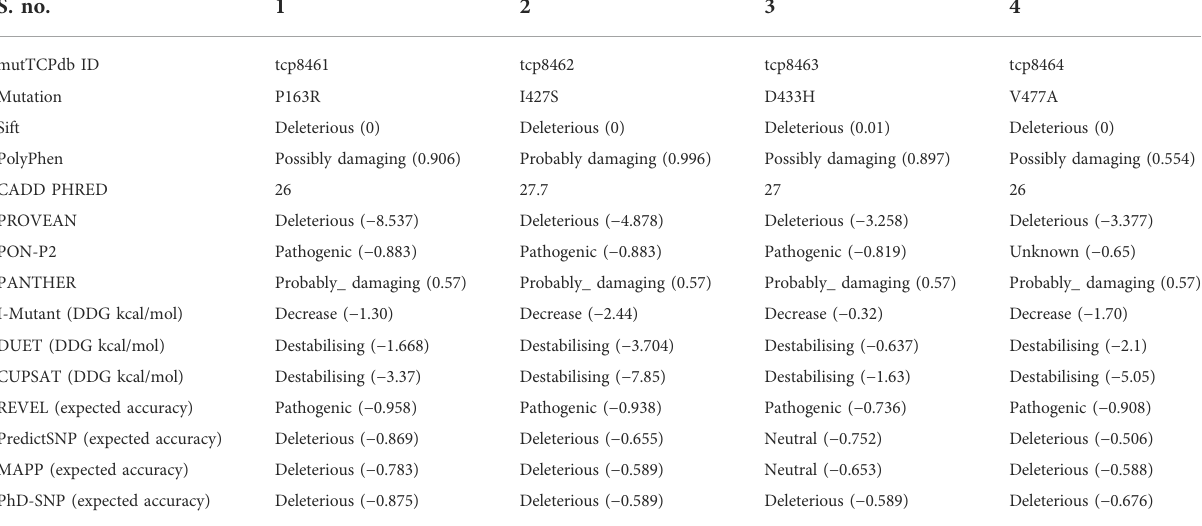
TABLE 1 Tabular record of in-silico method analysis result to predict the impact of SNVs over structure and functions. S.